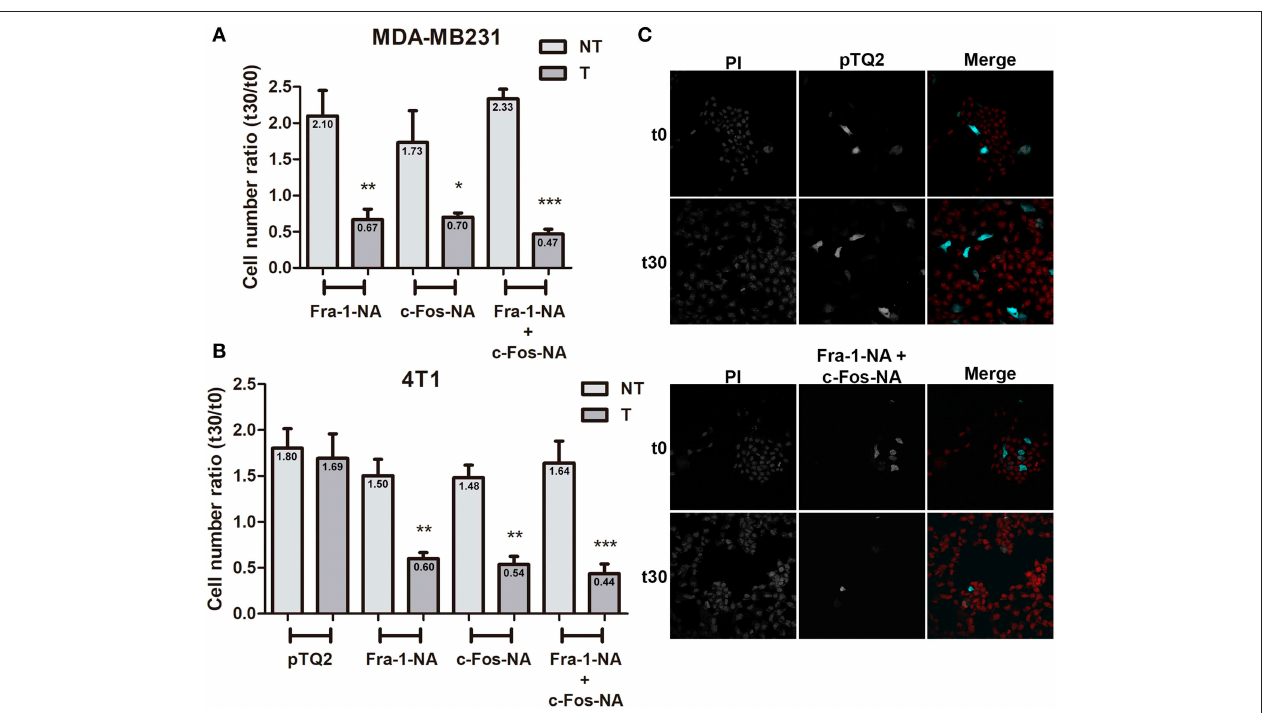
FIGURE 4 | Fra-1-NA and c-Fos-NA inhibit MDA-MB231 and 4T1 cell proliferation. MDA-MB231 (A) or 4T1 cells (B) were transfected to express pTQ2-Fra-1-NA, or pTQ2-c-Fos-NA, or pTQ2-c-Fos-NA + pTQ2-Fra-1-NA. The number of cells expressing the turquoise fluorescent protein (T: dark gray bars) and the number of non-transfected (NT: light gray bars) cells (propidium iodide stained cells—turquoise cells) present in the same well were counted at 0h (arrested cells: t0) and 30h after a mitotic stimulus (20% fetal bovine serum: t30). The ratio between the number of T or NT cells at t30 and t0 is shown and the mean indicated in each bar. Results are expressed as mean ± SEM ( n = 3). * p < 0.05; ** p < 0.01 *** p < 0.001 (ANOVA, Bonferroni post-test). (C) Representative images of 4T1 cells at t0 (arrested cells) and t30 (after 30h of a mitotic stimulus) of the control condition transfected with the pTQ2 vector (upper panel) and the condition transfected with pTQ2-c-Fos-NA + pTQ2-Fra-1-NA (lower panel). Total cells stained with PI (left column), and transfected cells (middle column) are shown in black and white and the colored merge in right column. PI: propidium iodide (red), TQ2 (cyan). Original Magnification 400 ×